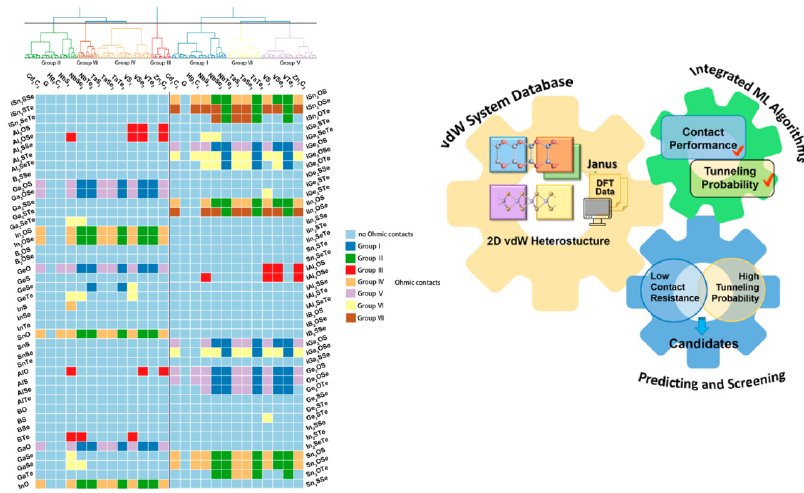
Figure 34. The application of machine learning in material screening. Reprinted with permission from Ref. [214]. Copyright 2022, copyright the American Chemical Society. More details on Copyright and Liscensing are available via the following link: https://pubs.acs.org/.